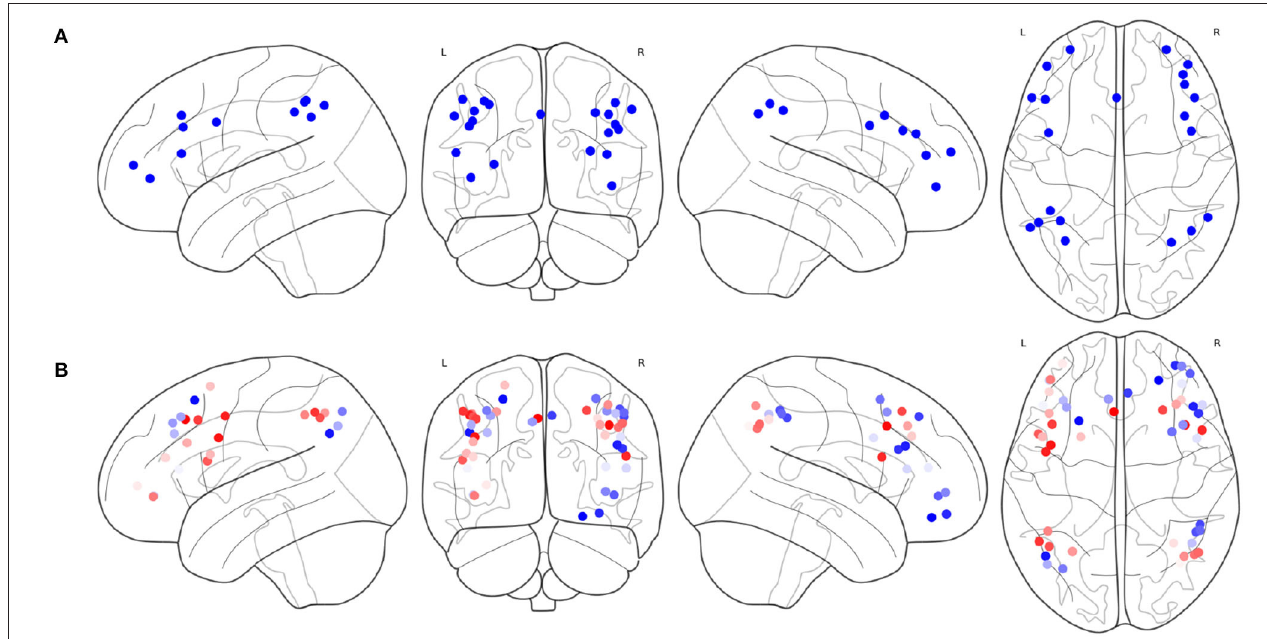
FIGURE 6 | Results of the main FPN and supplementary FPNs, (A) the ROIs in MainROIs , i.e., the FPN in Dosenbach-160, (B) the ROIs in all the supplementary FPNs, i.e., the FPNs in AAL, Power-264, and Willard-499. ROI with warmer colors has a higher priority in SuppROIs . Conversely, ROI with cooler color has a lower priority in SuppROIs